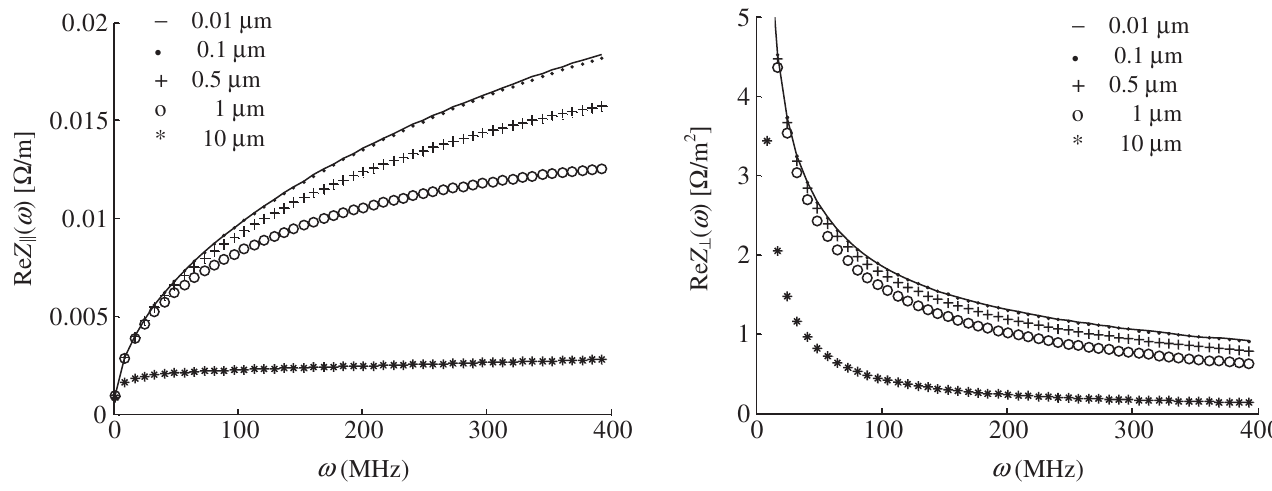
FIG. 3. Real part of longitudinal (left) and transverse (right) impedance per unit length for different thickness of inner layer (CSNS